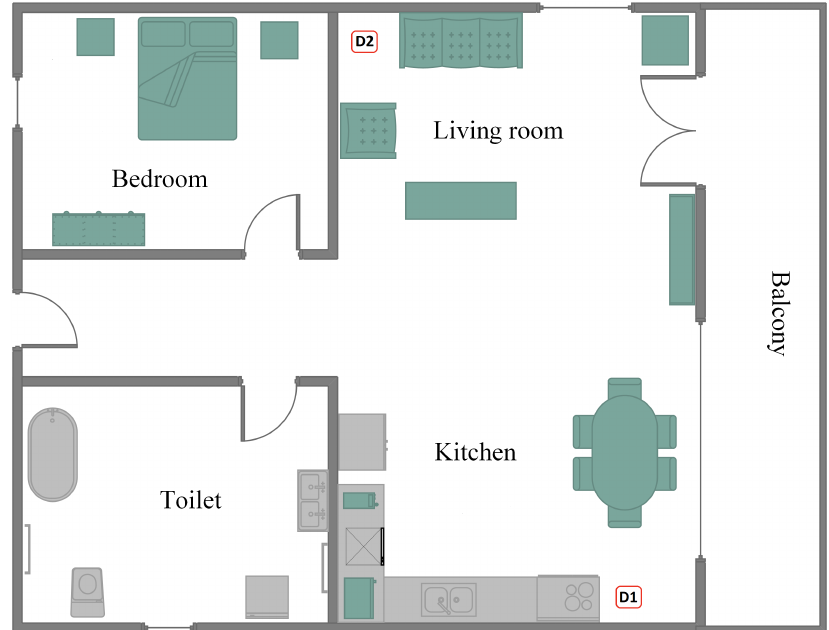
Figure 6. A typical household environment, used in a case study of the proposed system’s evaluation.